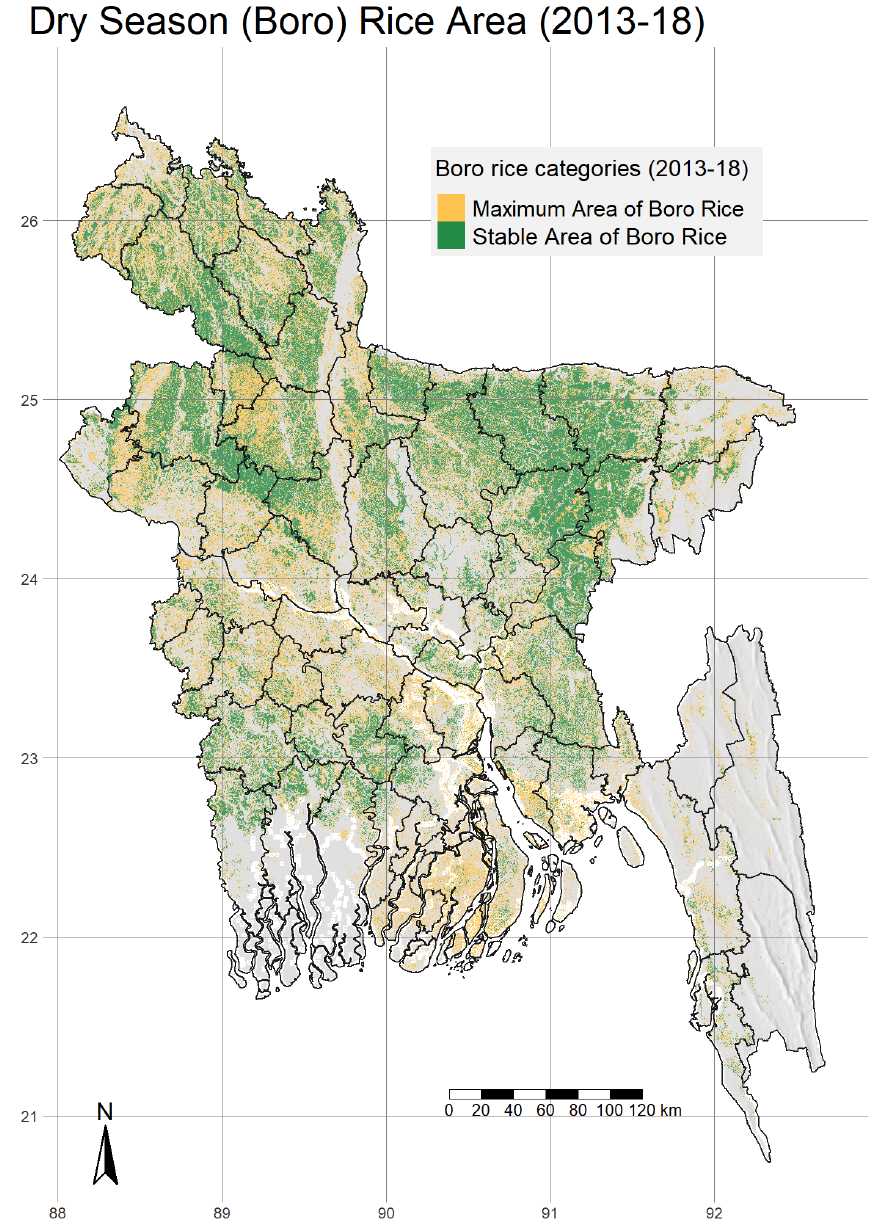
Figure 4. HTS-VIs rice map of Bangladesh based on the Landsat Archive, 2013 – 2018 crop years.